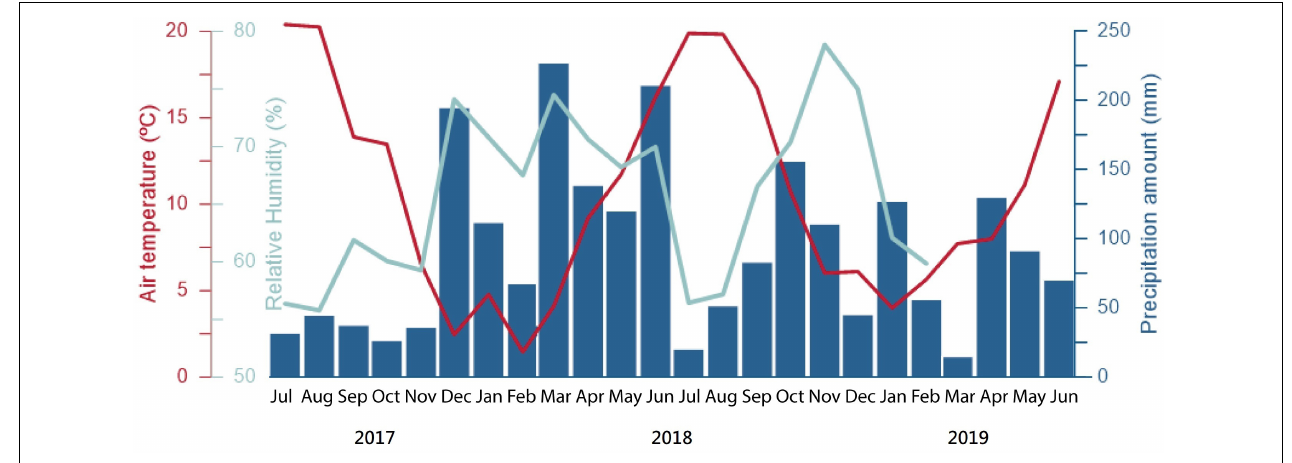
FIGURE 2 | Monthly precipitation amount at the sampling site, mean monthly air temperature, and mean monthly relative humidity based on data obtained from DGT meteorological station at Villanúa during the 2-year monitoring period.